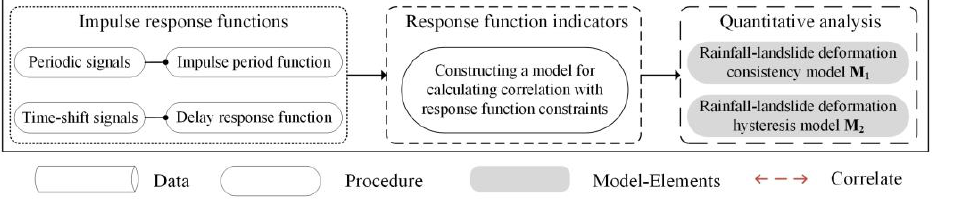
Figure 5. Flow chart of the regional rainfall-induced landslide deformation quantitative response analysis